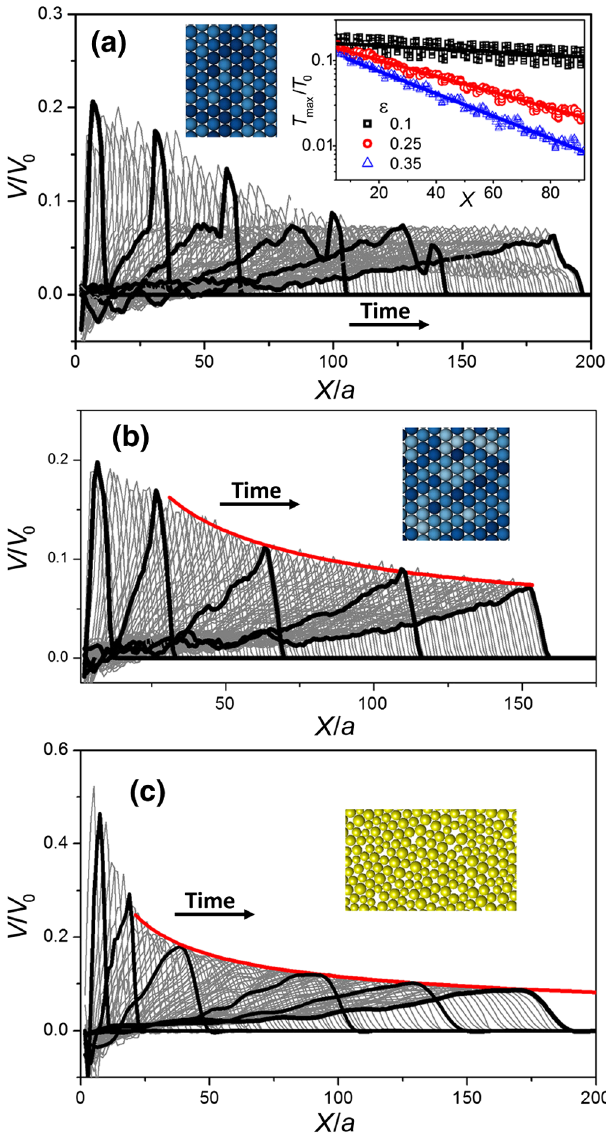
FIG. 3. (a) The time evolution in response to an impulse in a hexagonal packing with weak mass disorder characterized by the standard deviation in mass distribution ϵ . An impulse response generates a solitary-wave excitation that decays exponentially at early times. In the long-time limit, a shocklike triangular profile emerges whose leading edge decays as a power law with an exponent x − 0 . 5 (solid red line). (b) The time evolution in response to an impulse in a hexagonal packing with strong mass disorder ϵ . An impulse response generates a solitary-wave excitation, but the regime of exponential attenuation is barely identifiable. (c) Time evolution in response to an impulse in a jammed amorphous packing prepared at low pressure. The initial impulse still generates a solitary wave excitation but like in (b), a shock like triangular profile soon emerges whose leading edge decays as a power law with an exponent x − 0 . 5 (solid red